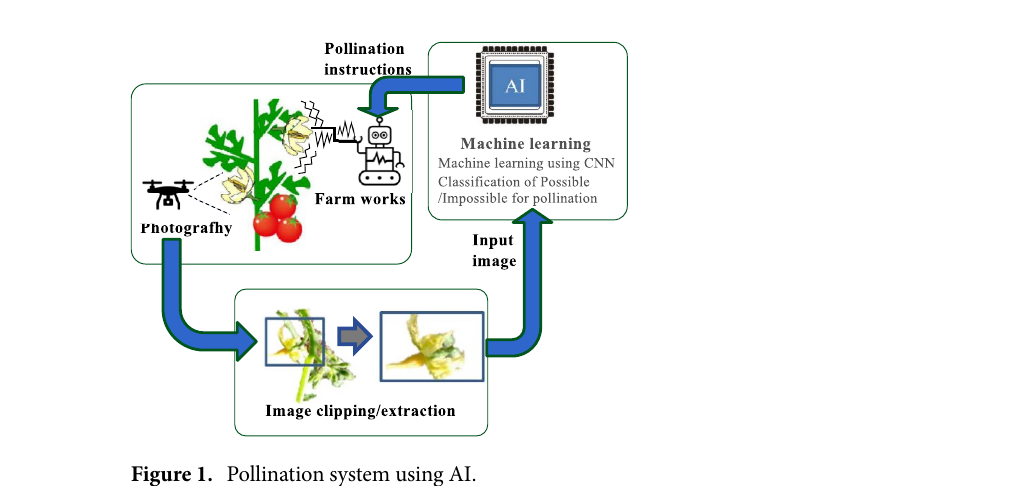
Figure 1. Pollination system using